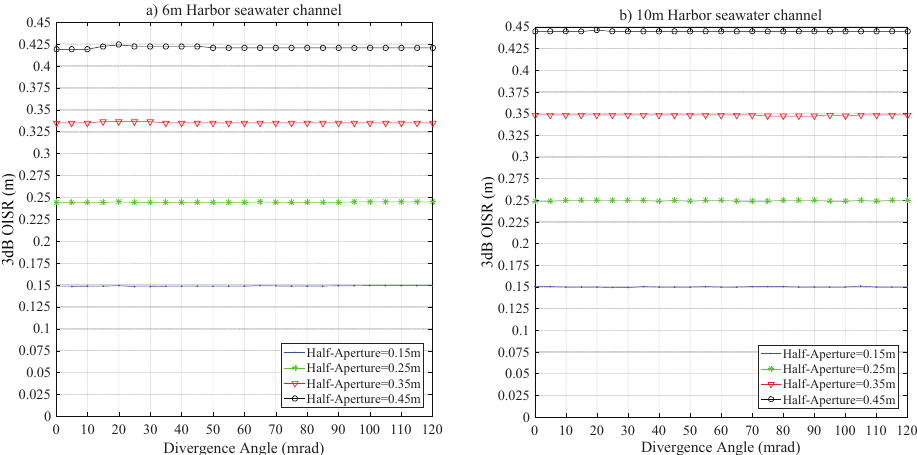
Figure 15. The r 3 dB versus T-Phai for the harbor seawater laser channel for a link distance of ( a ) 6 m and ( b ) 10